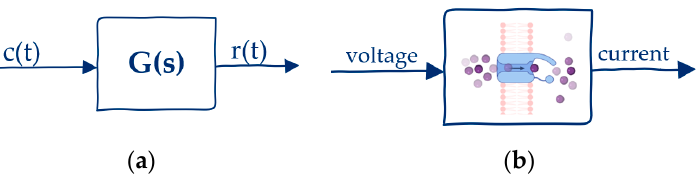
Figure 2. Block diagram of a system ( a ); illustrated voltage-gated ion channel as a system ( b ).